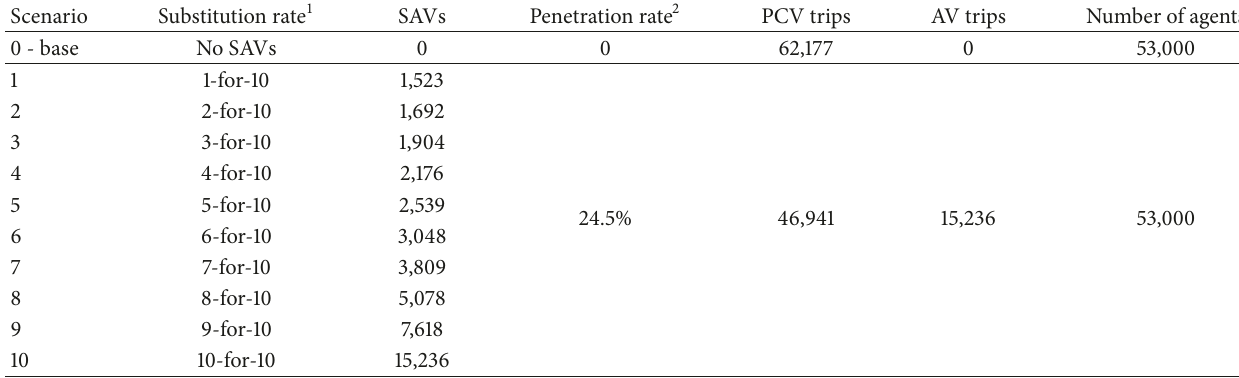
Table 1: Simulated scenarios (agents, trips, and vehicles already scaled to 5%).